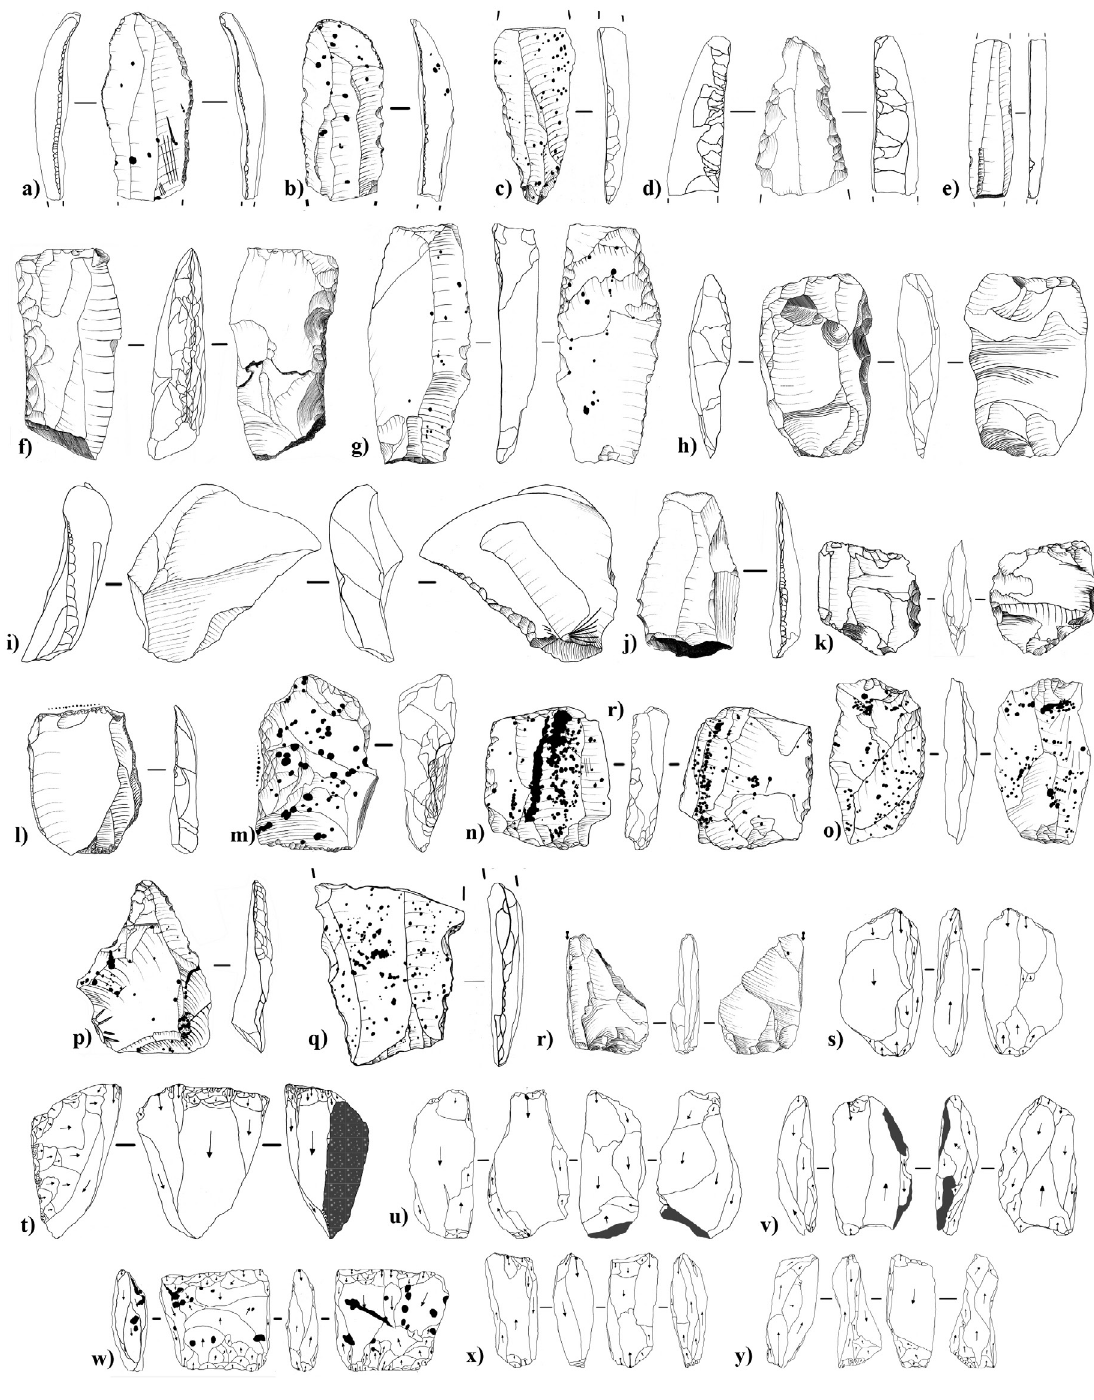
Figure 3. Examples of the obsidian assemblage at San Vincenzo. a. b. f. blade scrapers; c. d. h. backed blades; g. q. trunca- tions; i-o flake scarpers; p. point; r. burin; s-y cores (D.